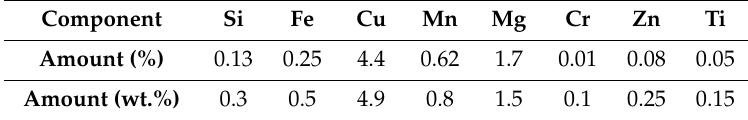
Figure 1. Station for the experimental tests (1—FlexText SE40 controller; 2—testing machine; 3—specimen; 4—ARAMIS 3D 4M system). Table 1. Chemical composition of the analyzed alloy.